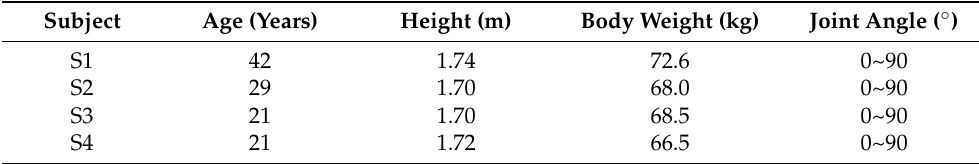
Table 2. Anthropometric data.